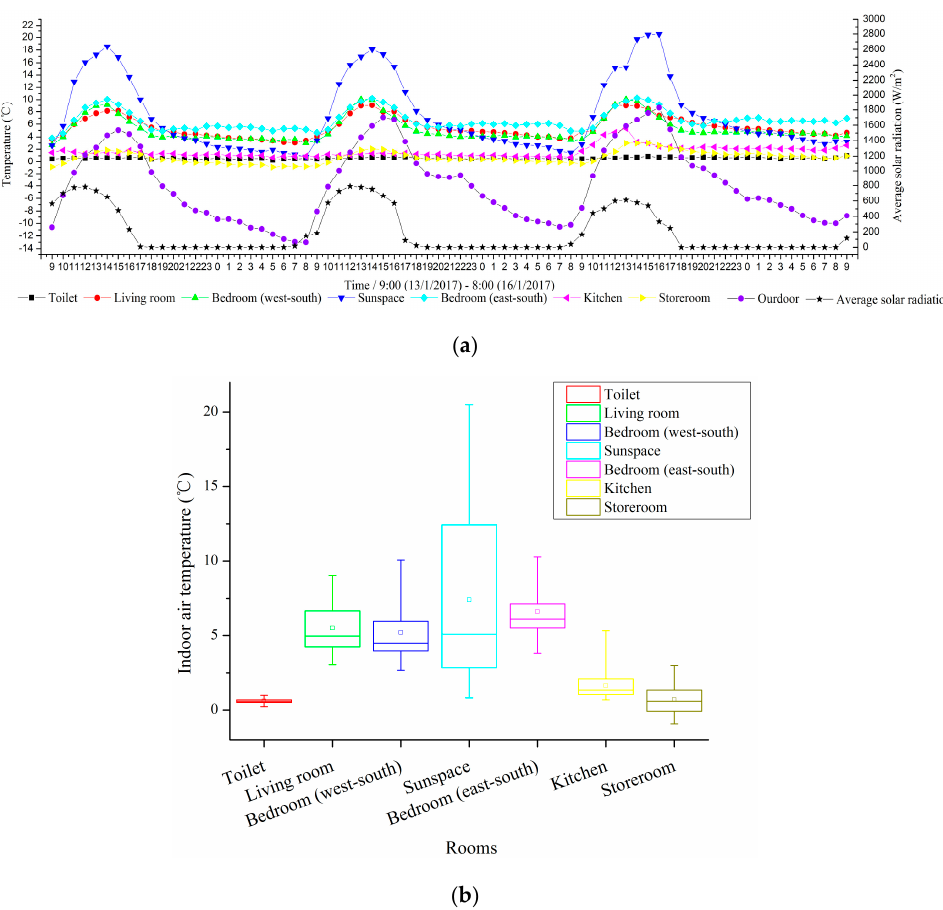
Figure 5. Average air temperature of each room (passive solar heating condition); ( a ) Hourly average temperature variation; ( b ) Hourly average temperature histogram.